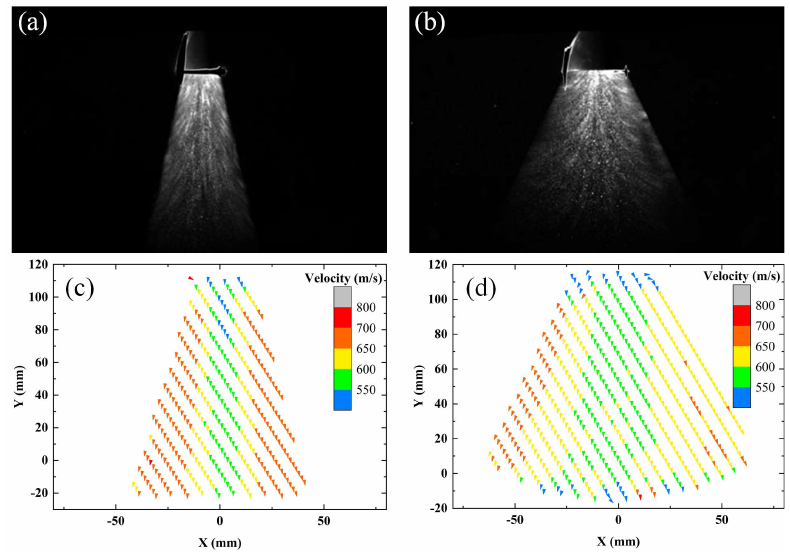
Figure 6. ( a ) Representative snapshots captured by the particle image velocimetry (PIV) of the ( a ) conical nozzle and ( b ) bell nozzle fed with the cold N 2 . The corresponding calculated velocities are shown in ( c , d